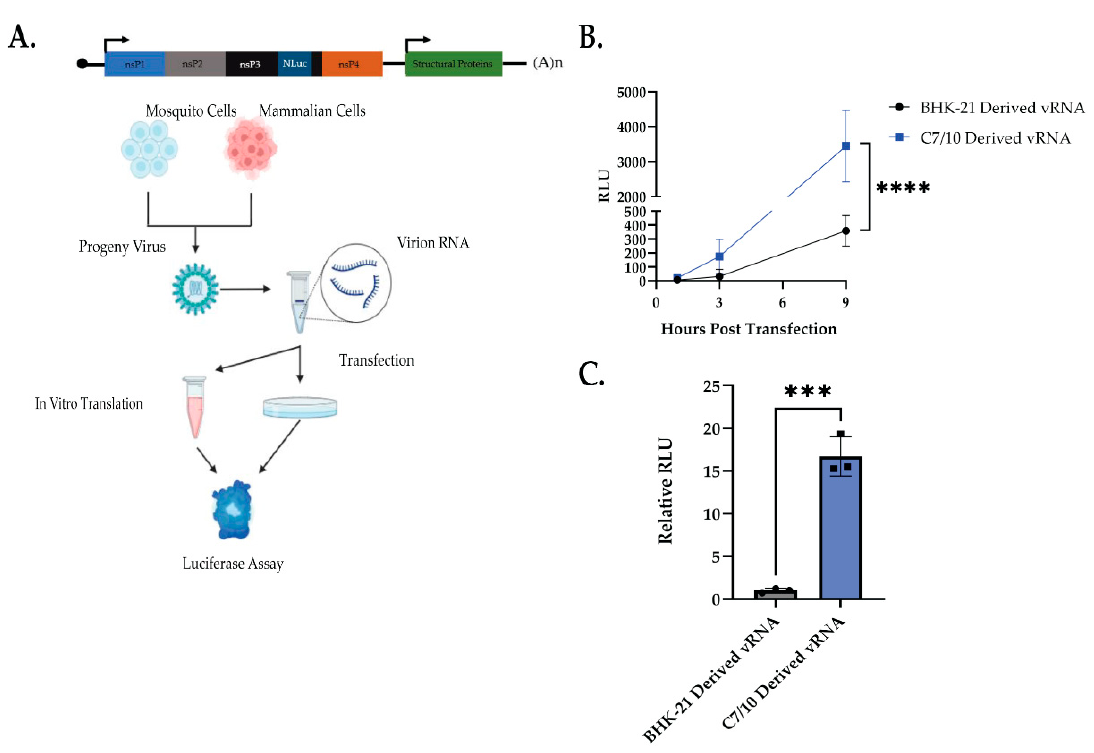
Figure 3. Purified viral RNA phenocopies encapsidated virions. ( A ) Schematic representation of experiment performed. ( B ) A total of 10 8 copies, determined by qRT-PCR, each of viral RNA extracted from BHK-21- and C7/10-derived viruses were transfected into naïve HEK-293 cells. Cell lysates were harvested at the indicated times and luciferase activity (RLU) was used as a proxy for viral replication. Error bars represent SEM of biological replicates ( n = 3) Two-way ANOVA using Sidak’s multiple comparisons: Time— p < 0.0001, BHK/C7-derived vRNA— p = 0.005, time × BHK/C7-derived vRNA— p = 0.0004. **** p < 0.0001. ( C ) A total of 10 8 copies each of viral RNA extracted from BHK-21- and C7/10-derived viruses were used for in vitro translation using Rabbit Reticulocyte Lysate (Promega). RLU was standardized to BHK-21-derived vRNA. Error bars represent SEM of biological replicates ( n = 3). Student’s t-test: p *** = 0.0003.